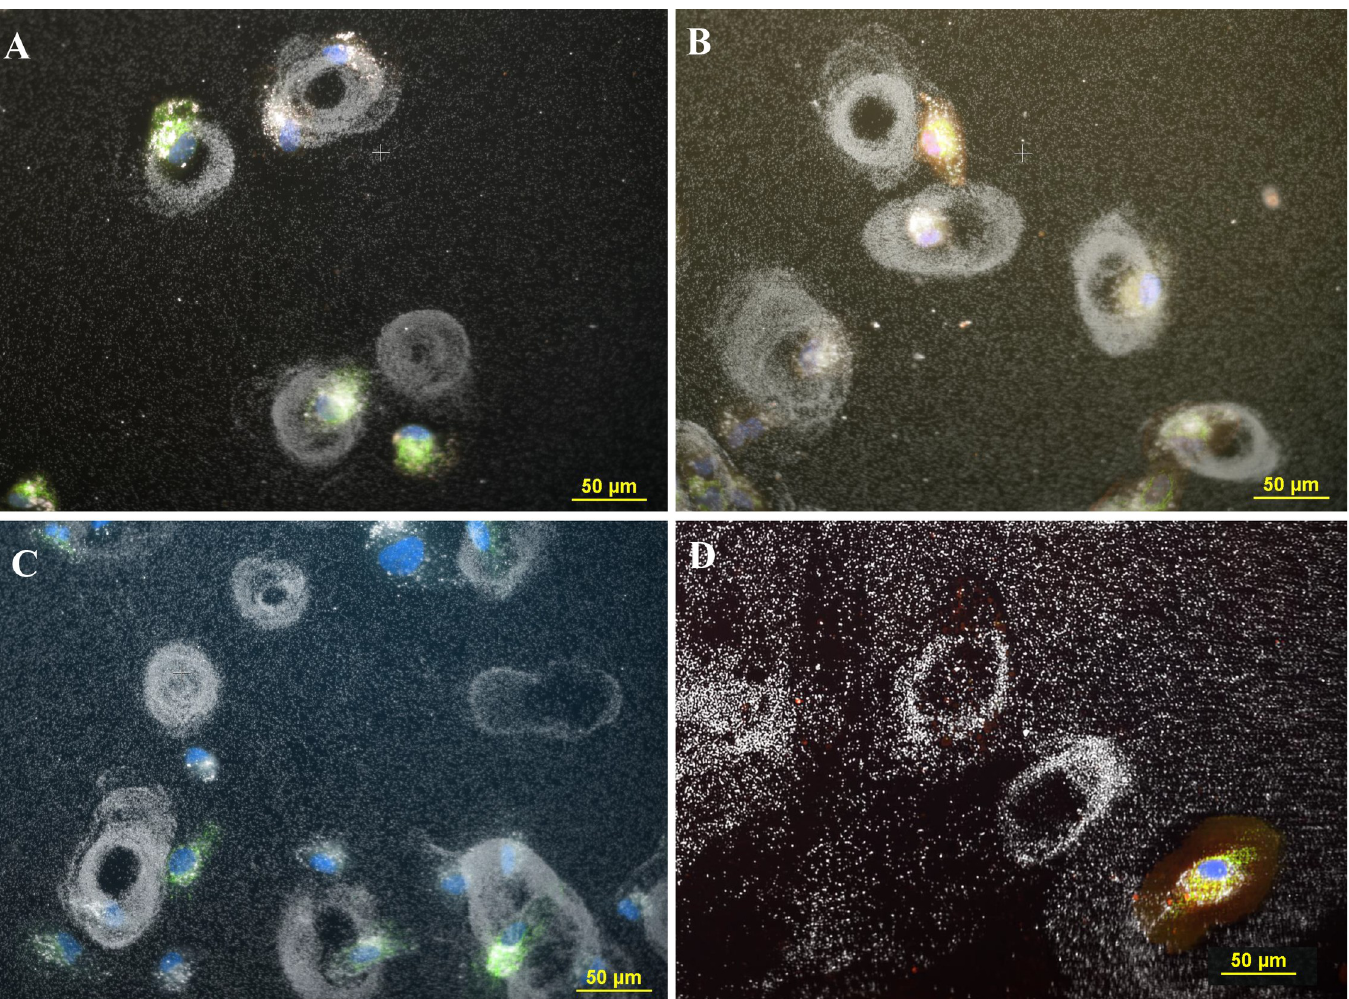
Fig 1. The images in Fig 1 (all panels) show ARPE-19 cells incubated with 3 μ g/ml AgNP citrate. The cells were transfected with mitochondria-GFP (green), stained with CellMask Orange plasma membrane stain (C10045, red), fixed with 4% PF, and mounted with Prolong gold that contained DAPI to stain the nuclei (blue). This allowed for the visualization of cells, and nanoparticles (white) due to reflected light in the darkfield images. The images were observed using a 20x multi-immersion objective (NA 0.75). The images in each panel are a darkfield image and fluorescence images that were acquired sequentially and then combined into one composite image. Panel A. Image of four rings of silver nanoparticles on the cell culture slide. Cells are nearby or adjacent to the rings. Magnification 200x. Panel B. Image of five rings and adjacent cells. Magnification 200x. Panel C. Image of six rings and multiple cells. Magnification 200x. Panel D. Image of two circular structures consisting of nanoparticles, and a cell that was stained with CellMask Orange plasma membrane stain (C10045), transfected with mitochondria-GFP (green) and stained with DAPI (blue) to reveal the nucleus. The cell in the Panel D is about the same size as the nanoparticle circles in the image. Magnification 200x.